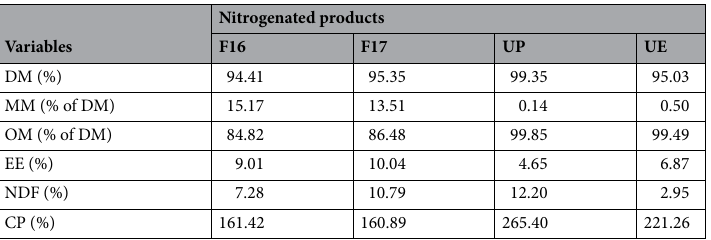
Table 1. Chemical composition of the different nitrogenous products evaluated. F16 = urea, sugarcane molasse, sulfur flower and calcium carbonate coated with carnauba wax; F17 = urea, cassava starch, sulfur flower and calcium carbonate; UP = polymer coated urea; UE = extruded urea (starea). DM: dry matter; MM: mineral matter; OM: organic matter; EE: ether extract; NDF: neutral detergent fiber; CP: crude